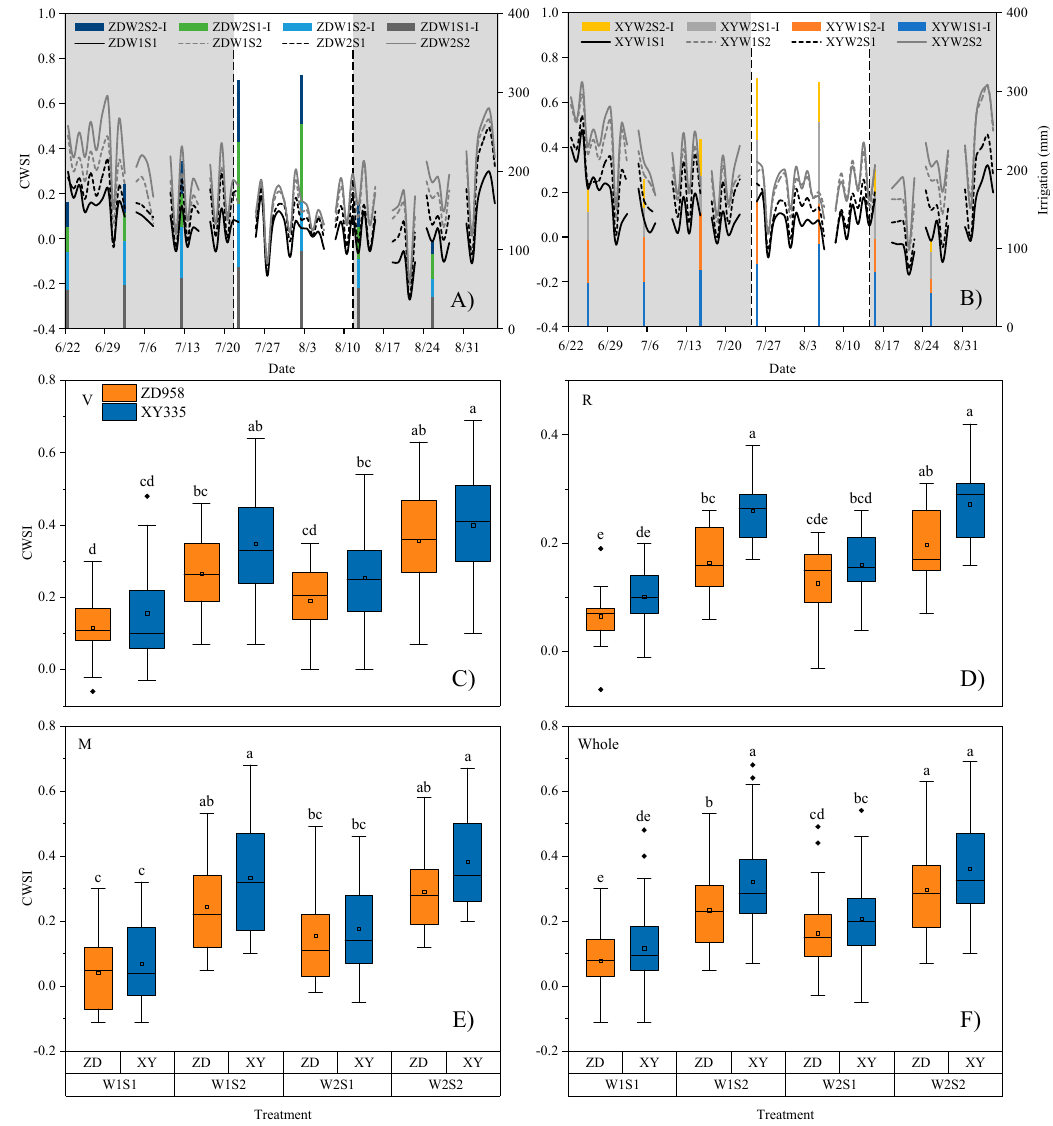
Figure 5. Seasonal variations in crop water stress index (CWSI) under different water and salt treatments for two maize genotypes, ( A ) ZD958 and ( B ) XY335, respectively, as well as average differences in CWSI during different and whole growth stages for two genotypes ( C – F ). Vertical dotted lines in ( A , B ) separate the growth stages into the late vegetative (V), reproductive (R), and maturation stages (M), respectively. Grey areas indicate periods when all treatments are deficit- irrigated. Vertical bars on the separate ordinates represent the amount of irrigation for each treatment of each irrigation. W1 and W2 are full and regulated deficit irrigation, and S1 and S2 salt-free and 2‰ soil salt content treatments, respectively. For the box plot, the lower and upper bounds correspond to the first and third quartiles (interquartile range, IQR), the horizontal lines inside the boxes are the medians, the upper/lower whisker extends from the bound to the largest/smallest value no further than 1.5 × IQR from the bounds, and data beyond the end of the whiskers are plotted individually. The differences in CWSI between two genotypes are analyzed by one-way ANOVA during different growth stages, respectively. Different letters denote significant differences ( p < 0.05) by a Tukey’s posthoc test for means comparison.